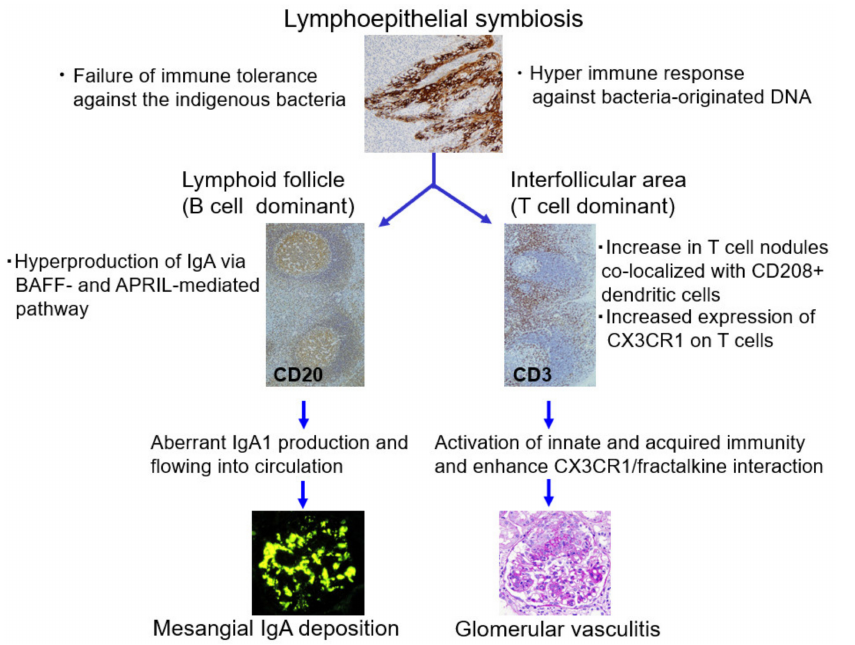
Figure 7. Role of palatine tonsils in the pathogenesis of immunoglobulin A nephropathy (IgAN). The palatine tonsil has a unique structure, namely, lymphoepithelial symbiosis, which functions as an induction site in the mucosal immune system. IgAN tonsils have characteristics such as failure of immune tolerance against indigenous bacteria and a hyperimmune response against bacteria- originated DNA. The overproduction of aberrantly glycosylated and polymeric IgA1 through BAFF and APRIL mediated T cell-independent pathways in lymphoid follicles in tonsils may be a source of mesangial IgA deposition. The increased number of T cell nodules co-localized with CD208+ dendritic cells in IgAN tonsils may be related to the enhanced expression of CX3CR1 in CD8+ cells and other types of lymphocytes with cytotoxic activity and the simultaneous upregulation of fractalkine/CX3CR1 interaction in distant glomeruli occurs, resulting in glomerular